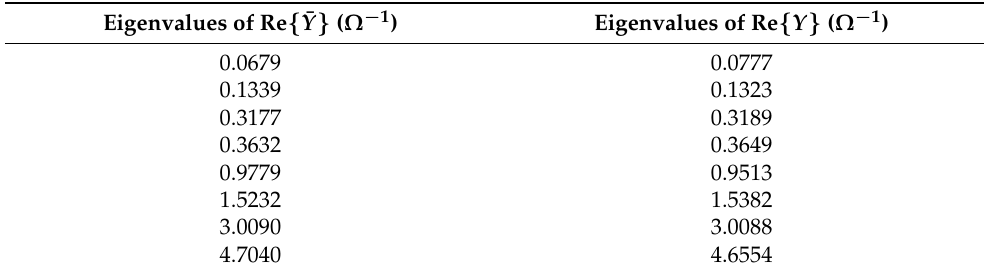
Table 2. Eigenvalues of the estimated conductance matrix Re { Y } compared to the eigenvalues of the actual conductance matrix Re { ¯ Y } in the case n =